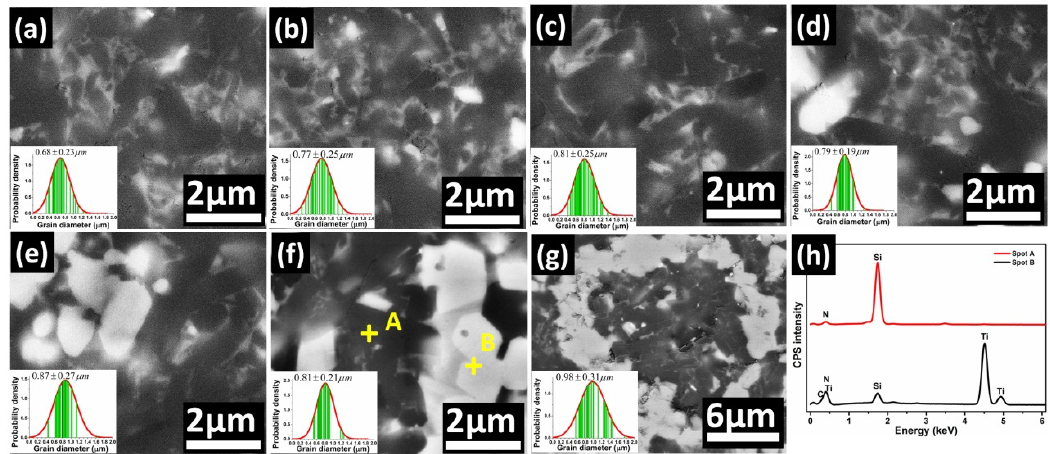
Table 1. Refinement parameters of Ti 3 SiC 2 doped Si 3 N 4 ceramics.